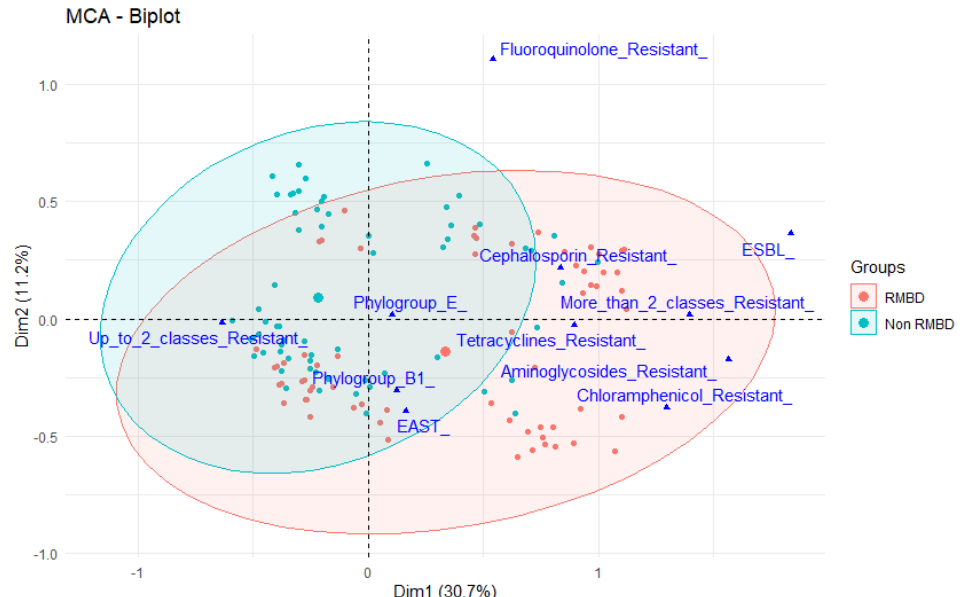
Figure 2. Multiple correspondence analysis (MCA) of categorical variables of E. coli from dogs fed raw meat-based diets (RMBDs) (red) or conventional dry feed (blue). This two-dimensional biplot graphic explains 41.9% of total variation and comprises 95% of E. coli isolates within the ellipse. Variables were considered to be associated when they plotted closely together. Table 3. Results of virulence factors and resistance gene detection and multilocus sequence typing (MLST) of the seven extended-spectrum beta-lactamase (ESBL)-positive E. coli isolates from six dogs fed raw meat-based diets in